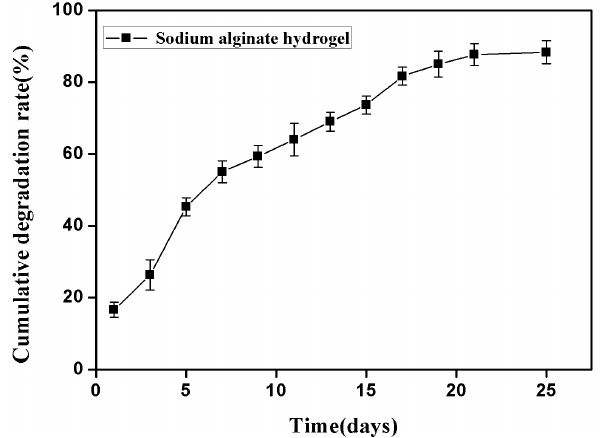
Figure 1. In vitro degradation of sodium alginate hydrogel formed with 3% sodium alginate aqueous solution and 5% aqueous calcium chloride solution in phosphate buffer solution (PBS) for 25 days at 37 °C.